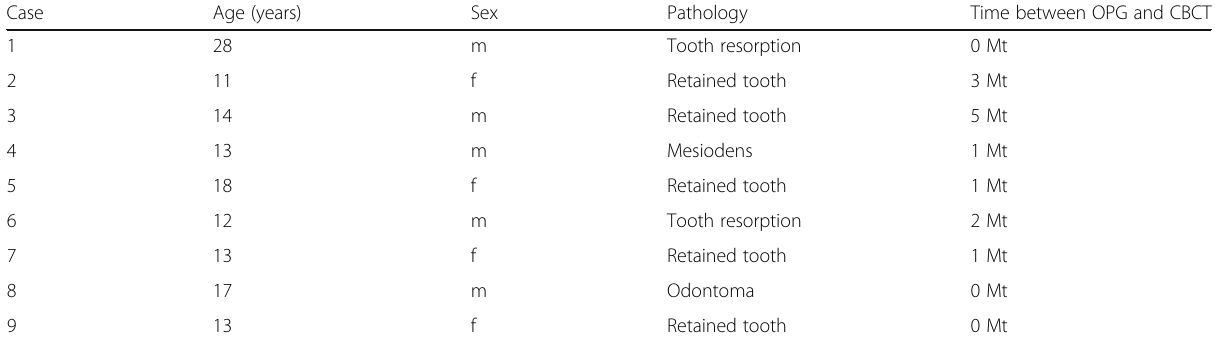
Table 2 Description of the cases assessed